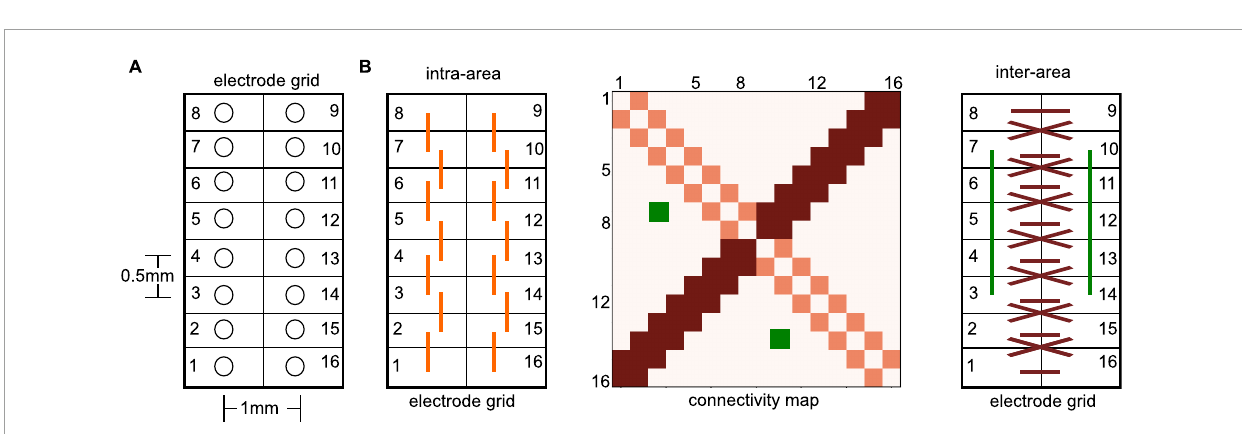
FIGURE2 Illustration of electrode grid and related connectivity map. (A) The electrode numbers increase on one side from the bottom to the top and further increase on the other grid side from top to bottom in a circle. This configuration implies opposite neighboring sites of, e.g., #1 and #16. It is important to mention that electrode grids have been positioned in the neural tissue in such a way, that each grid side captured activity from a single brain area. (B) Extracted connectivity maps (like the illustrated map in the center panel) exhibit certain patterns due to the spatial electrode locations in the electrode grid. For instance, nearest neighbor connections on the same grid side (left panel), i.e., the same brain area, are seen in the connectivity map (center panel) on the diagonal (light red). Symmetric nearest neighbor connections between opposite electrodes sites (right panel) show up in the connectivity map on the second diagonal (dark red). Symmetric non-diagonal connections (e.g., the green-coded connectivity map pixels) reflect connections symmetric on both grid